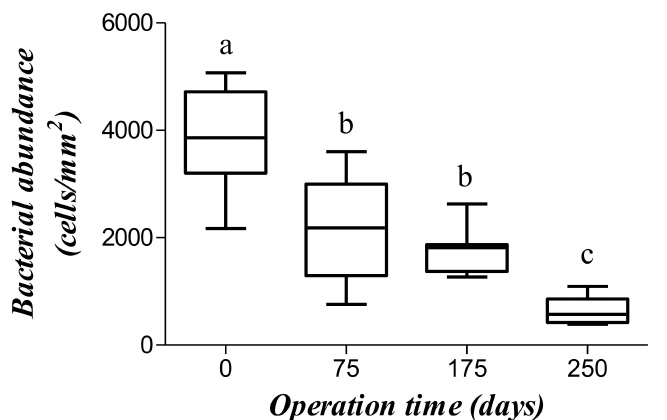
Figure 7. Bacterial abundance at distinct operation times. Boxes with distinct letters are significantly di ff erent ( p < 0.05, one-way ANOVA plus Tukey post-hoc